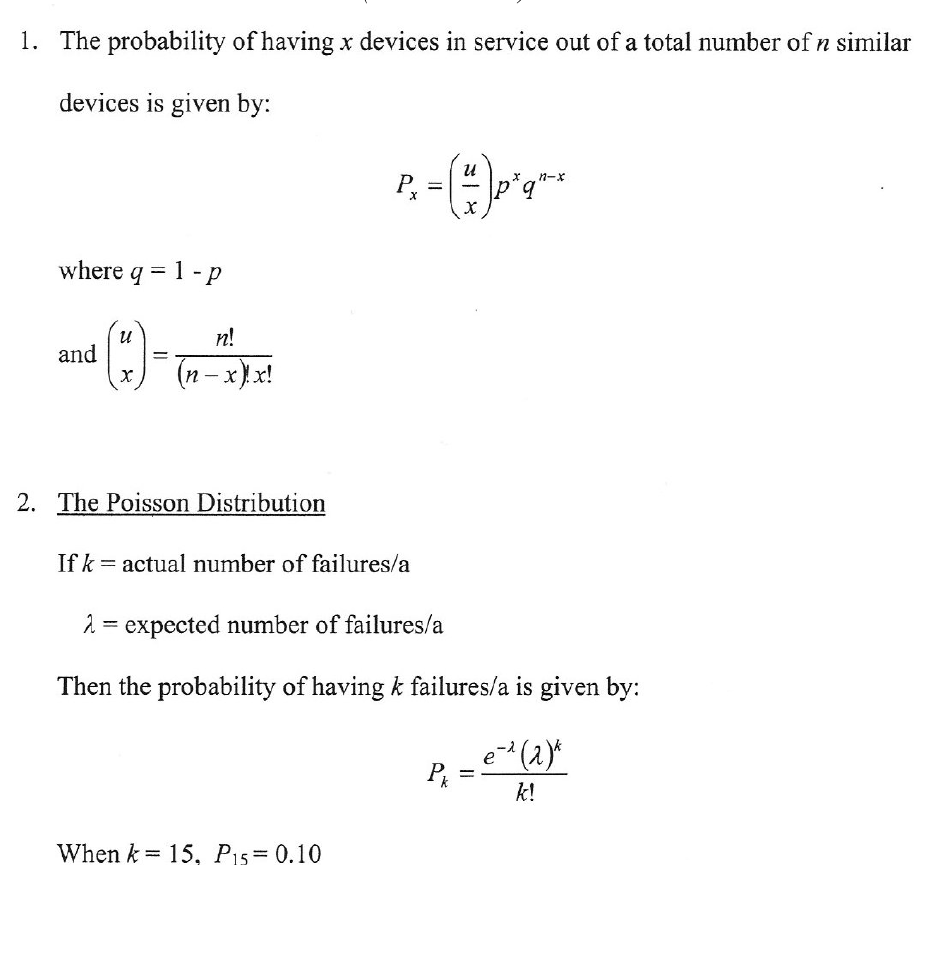
Figure 2. Availability and its